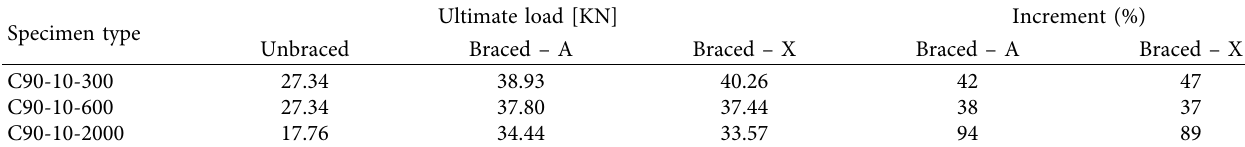
Table 1: Ultimate loads and increments of the first test series [1].